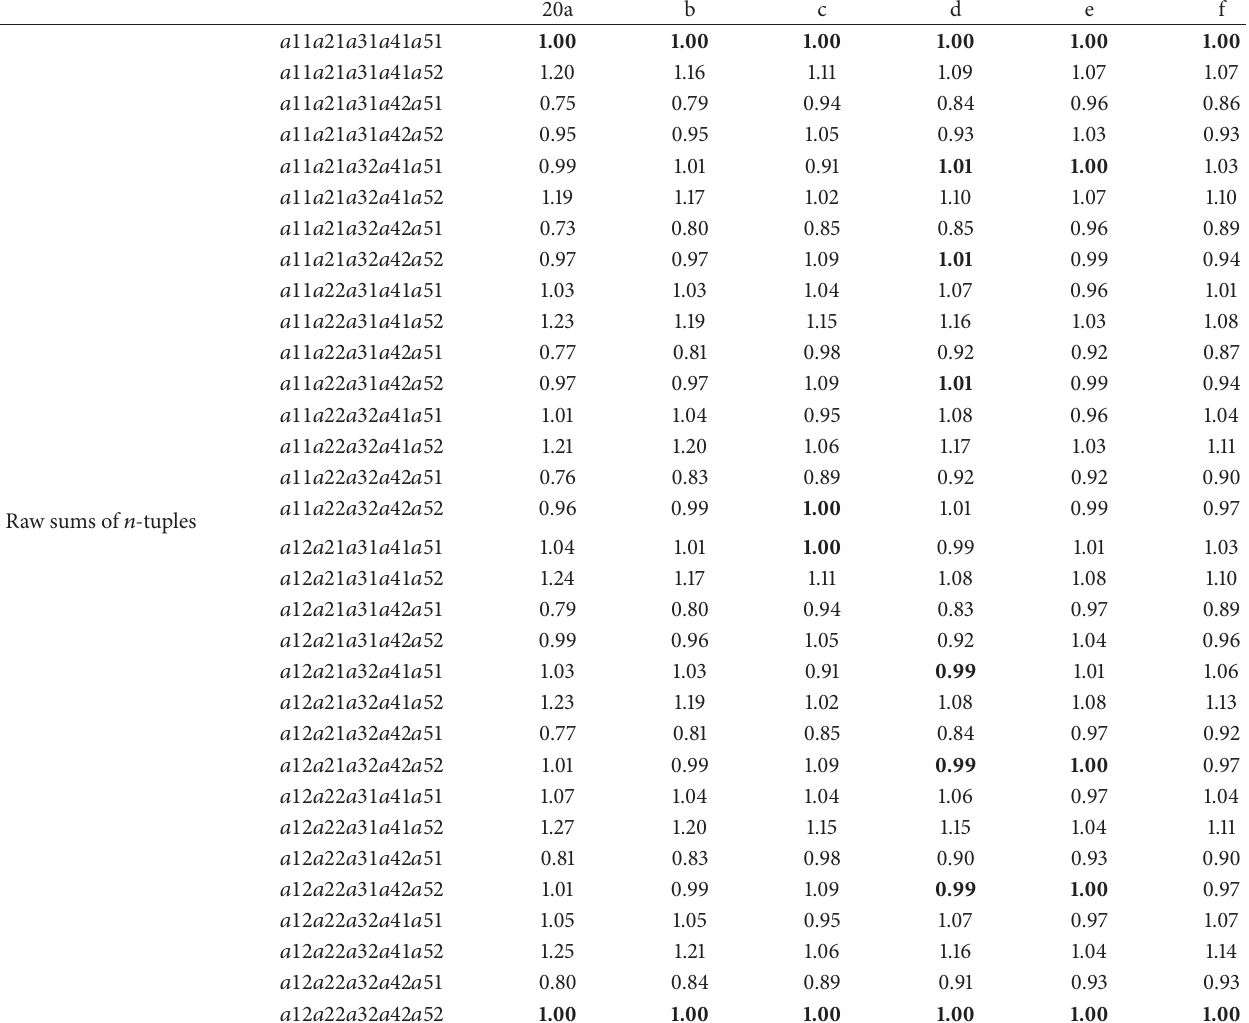
Table 4: 5-tuple sums of fuzzy probability combinations for Question